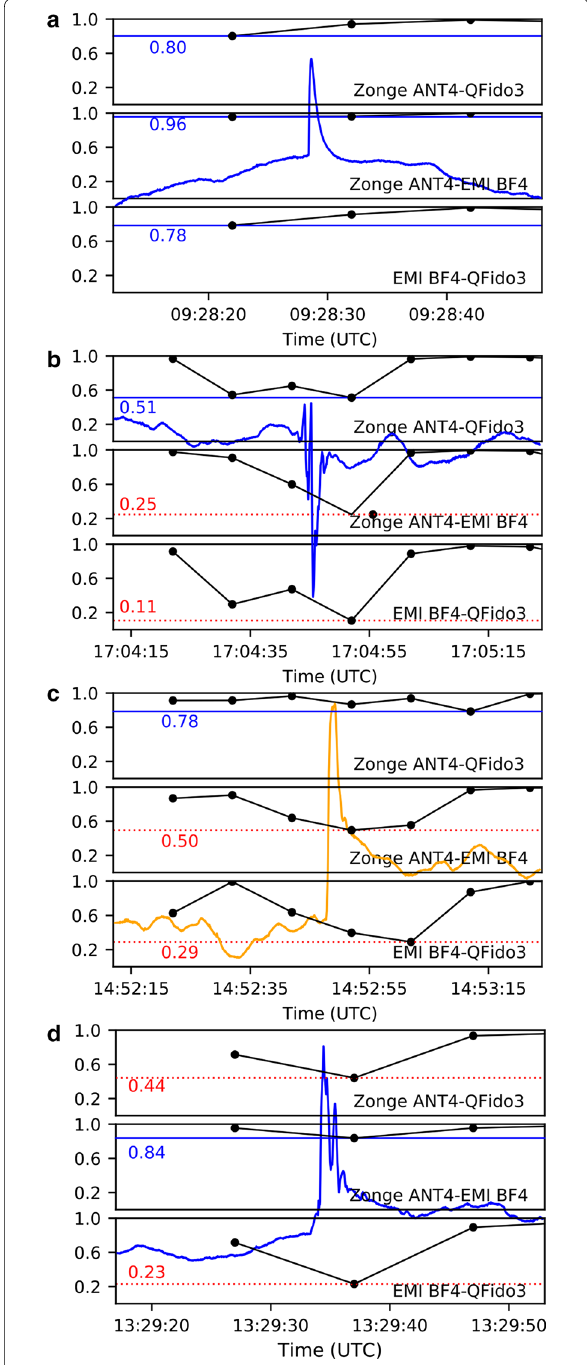
Fig. 13 Cross-correlation coefficients calculated as in Fig. 12 for the data shown in Fig. 10, labeled a – d , as in Fig. 10. Horizontal lines show the minimum correlation coefficient in each data segment. The horizontal line is shown in solid blue when the minimum coefficient is greater than 0.5; otherwise, the horizontal line is shown as dotted and colored red. Background trace in a , b , and d is the QFido3 record (blue here and Fig. 10a, b, d); background trace in c is the EMI BF4 record (orange here and in Fig.